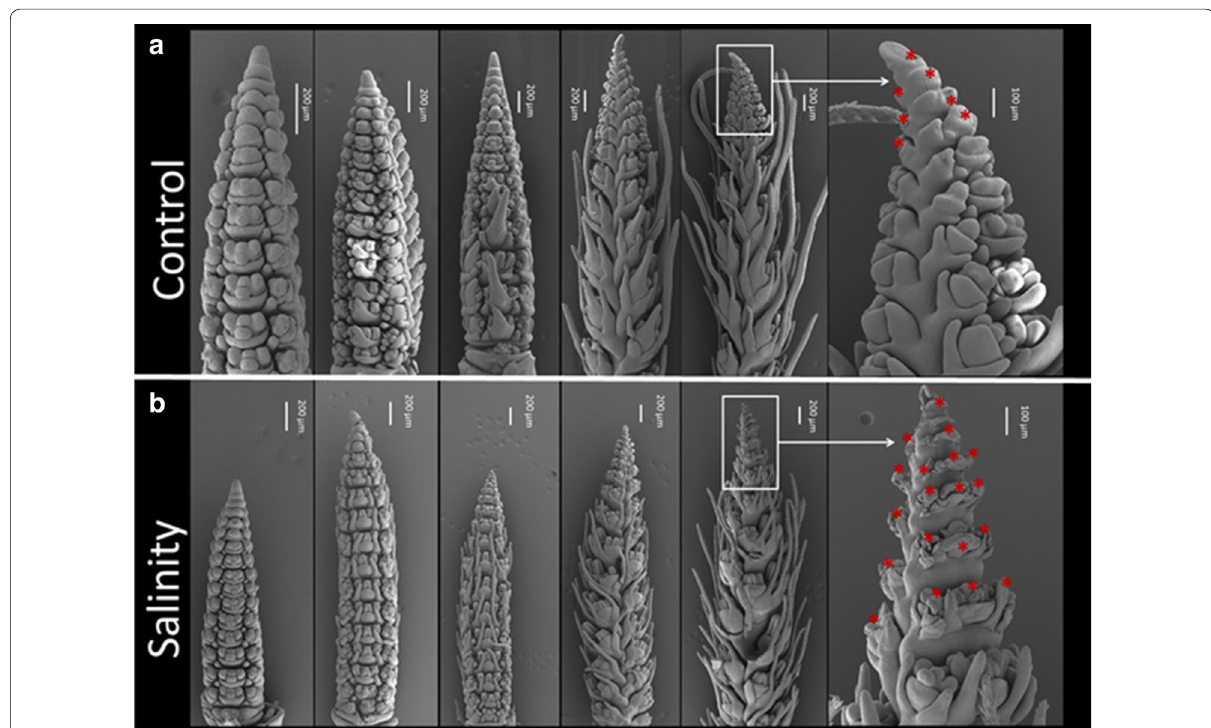
Fig. 4 Barley spike development under control ( a ) and salinity treatment ( b ) conditions. Red stars showed the undeveloped/later-aborted spikelets (color figure